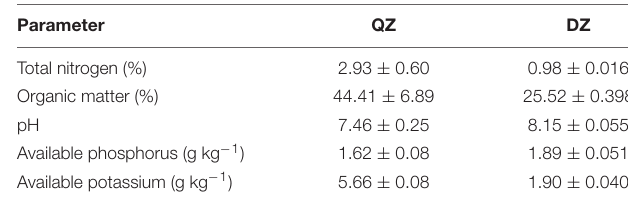
TABLE 1 | Physicochemical properties of cow manure compost (DZ) and chicken and cow co-compost